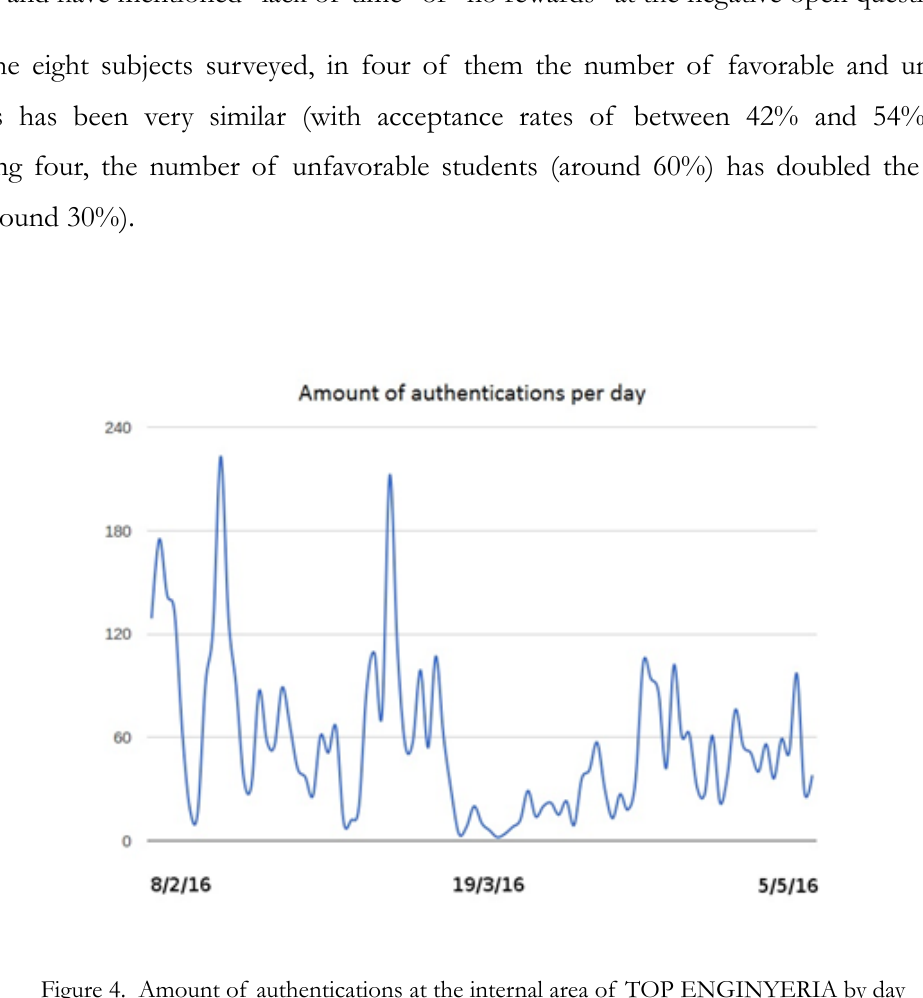
Figure 4. Amount of authentications at the internal area of TOP ENGINYERIA by